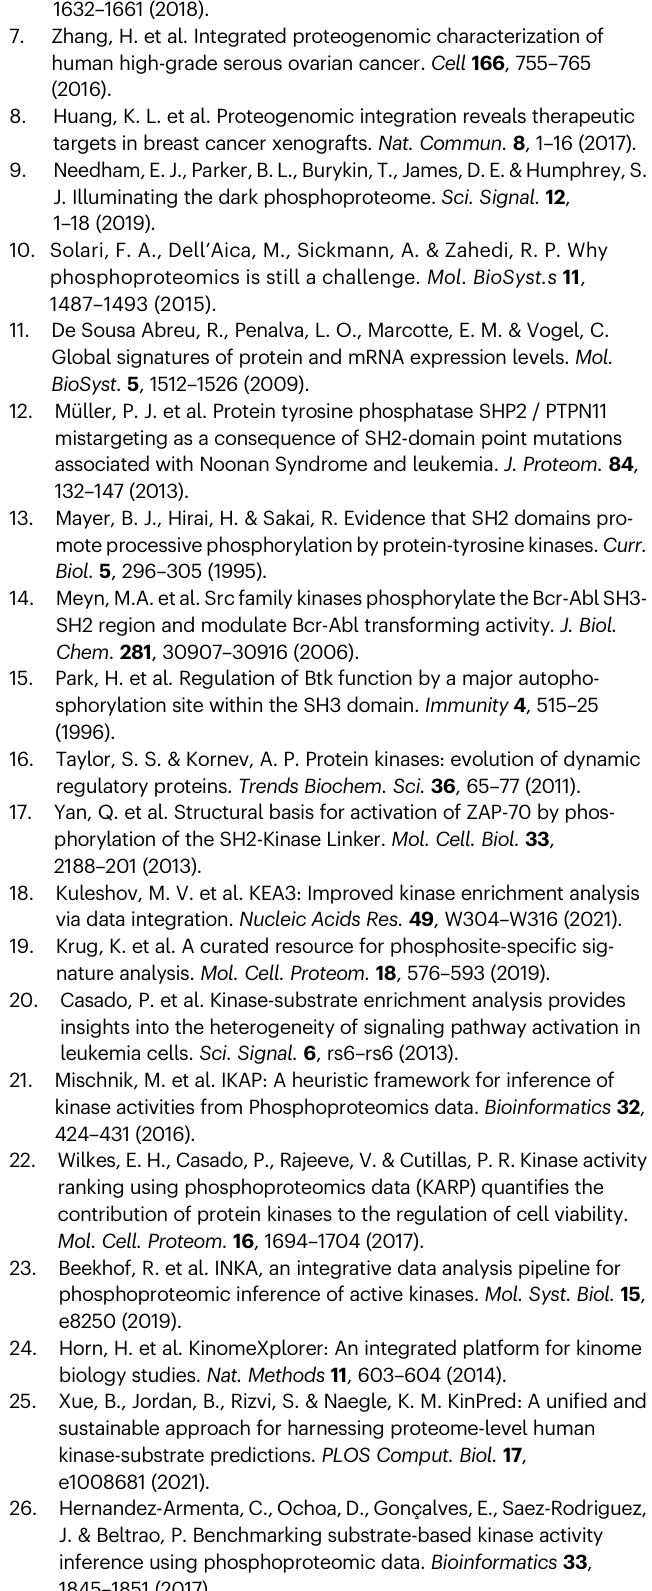
Fig. 6b: Supplementary Data 1 in Huang et al. 8 , Fig. 6c: Supplementary Table 1b from Satpathy et al. 4 ). Source data are also provided as a Source Data fi le. Source data are provided with this